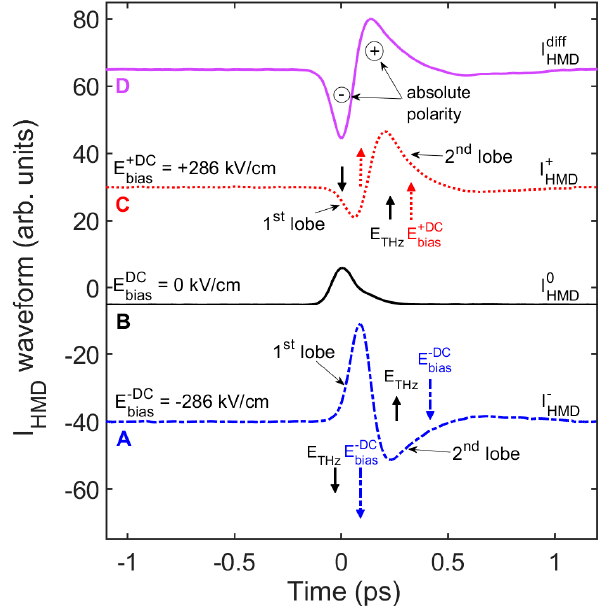
Figure 4. Recovery of the THz pulse absolute polarity. The temporal waveforms retrieved via the SSBCD homodyne scheme shows that, with respect to the non-biased case (curve B ), the first lobe is amplified by a negative bias (curve A ), whereas a positive bias causes its attenuation (curve C ). The opposite occurs for the second lobe. This suggests that the oscillation of the THz electric field wave begins with a “negative” cycle (curve D ). For all curves, the THz electric field strength is fixed at 150